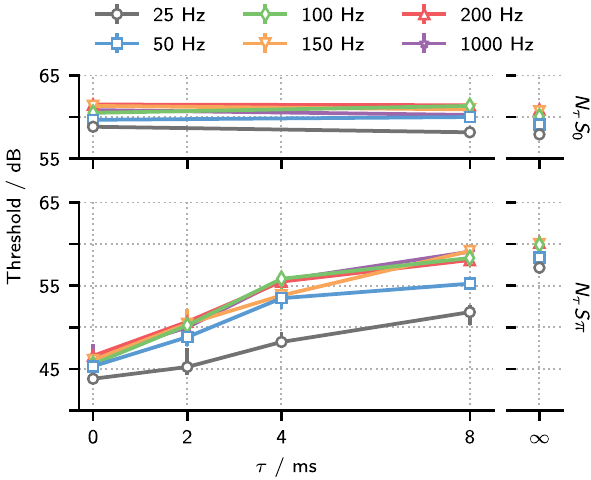
Figure 1. N s S 0 detection thresholds (upper panel) and dichotic N s S p thresholds (lower panel) as a function of noise ITD in ms. The separated data points at the right-hand side are for uncorrelated noise ( N u ). Different symbols (color online) are for the different noise bandwidths ranging from 25 Hz to 1000